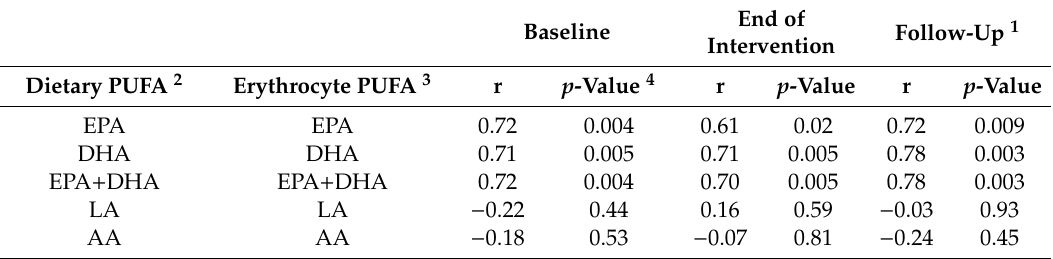
End of Baseline Follow-Up 1 Intervention